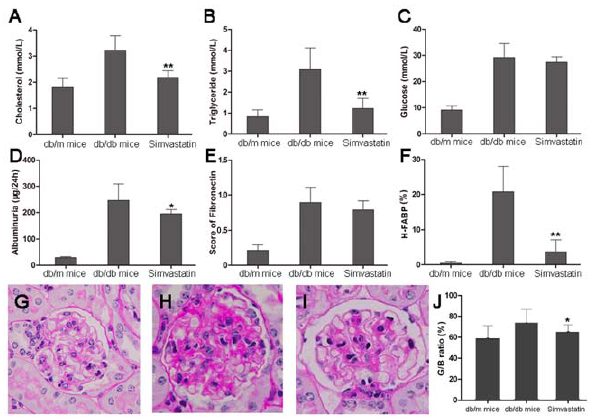
Figure 2. Characterization of H-FABP expression in patients with ORG and in db/db mice. A–D: ORG-affected kidney sections were examined for expression of H-FABP by immunofluorescence and confocal analysis: (A) H-FABP in red; (B) synaptopodin in green; (C) merge with original magnification 6 400 and (D) merge with original magnification 6 1640. It was clearly shown that H-FABP was co-localized with synaptopodin in cases of ORG, which is pointed to with white arrows. E–H: Immunoelectronic analysis was conducted to test the pattern of H-FABP expression, and staining was detected by H-FABP (E, *, 6 8,000) in the foot process and the cytoplasm of podocytes (F, 6 , 40,000), but not in the endothelial cell (G, 6 , 40,000) or the mesangial areas (H, 6 , 20,000). I: mouse H-FABP expression was examined by double immunohistological analysis in 20 week db/db mice, presenting H-FABP (in yellow), synaptopodin (in blue) and co- located (in black) staining. J–L: mouse H-FABP expression was examined by double immunofluorescence and confocal analysis in 20 week db/db mice: (J) H-FABP in red; (K) synaptopodin in green; and (L) merge showing co-localization in yellow.